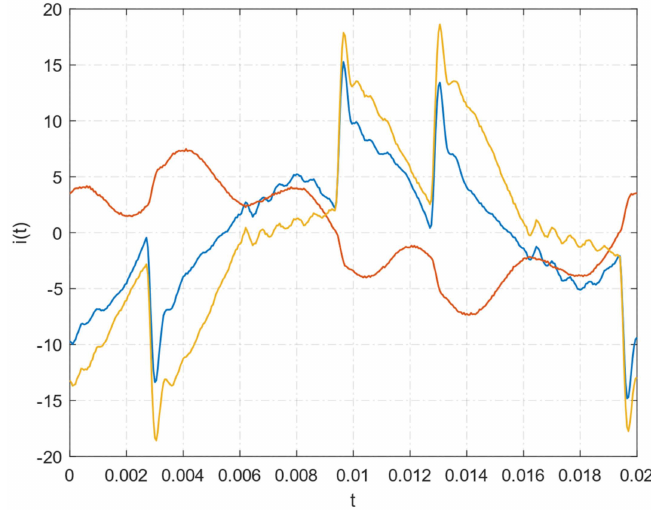
Figure 12. Current waveforms during experimental study: passive filter current i PF (red line), supply system current i T (blue line), calculated current i SUM (yellow line). Table 4. The relative error estimation for various modes of test bench